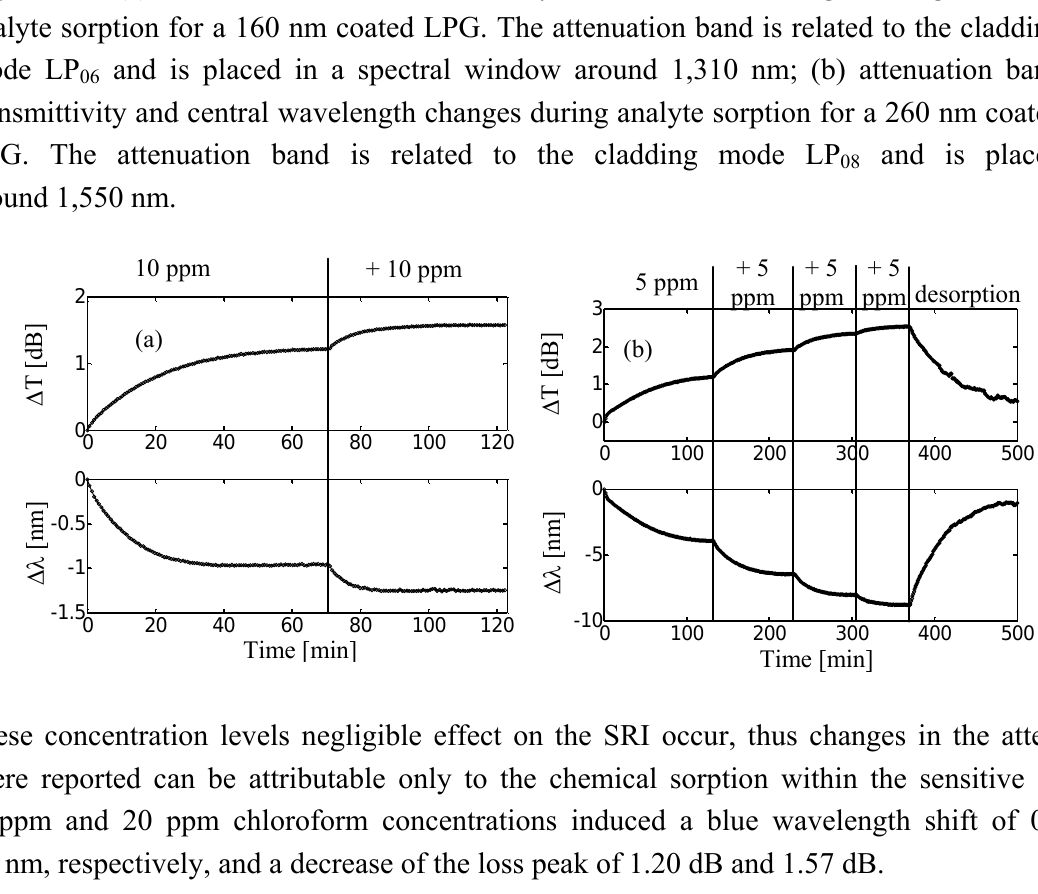
and is placed 08